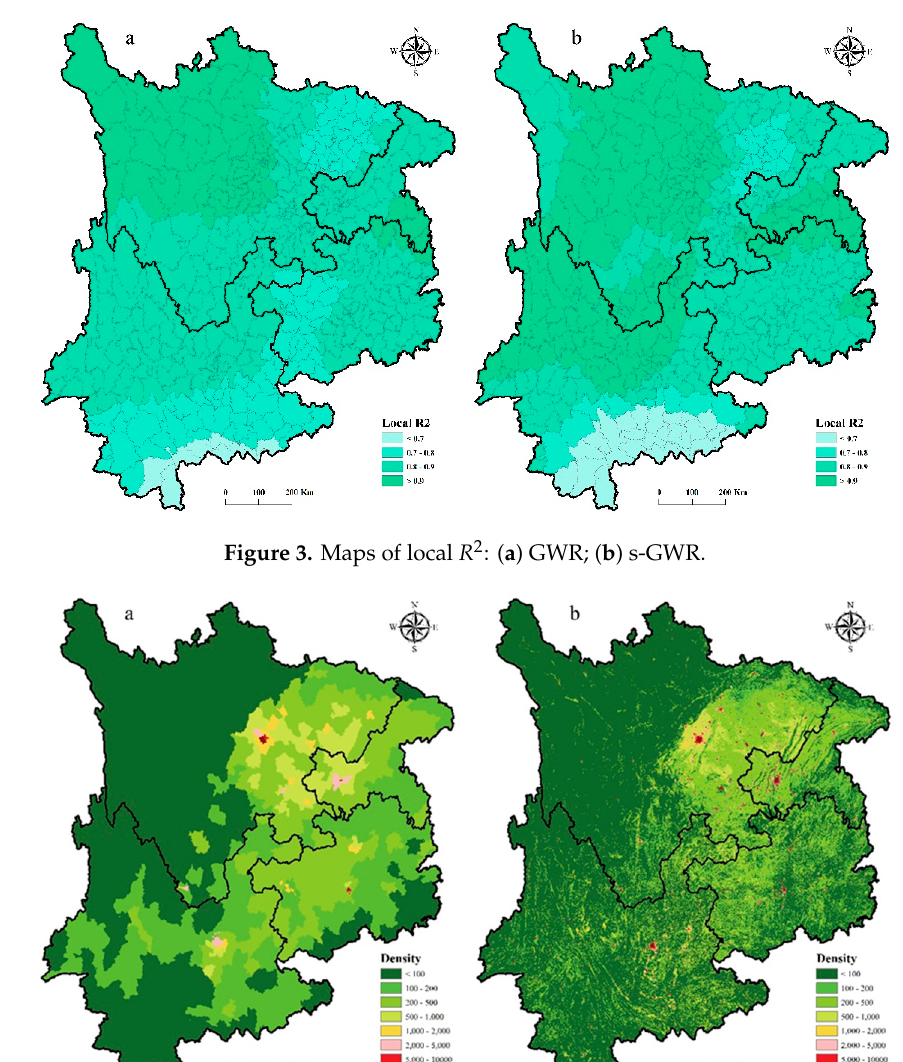
Figure 3. Maps of local R 2 : ( a ) GWR; ( b ) s-GWR.